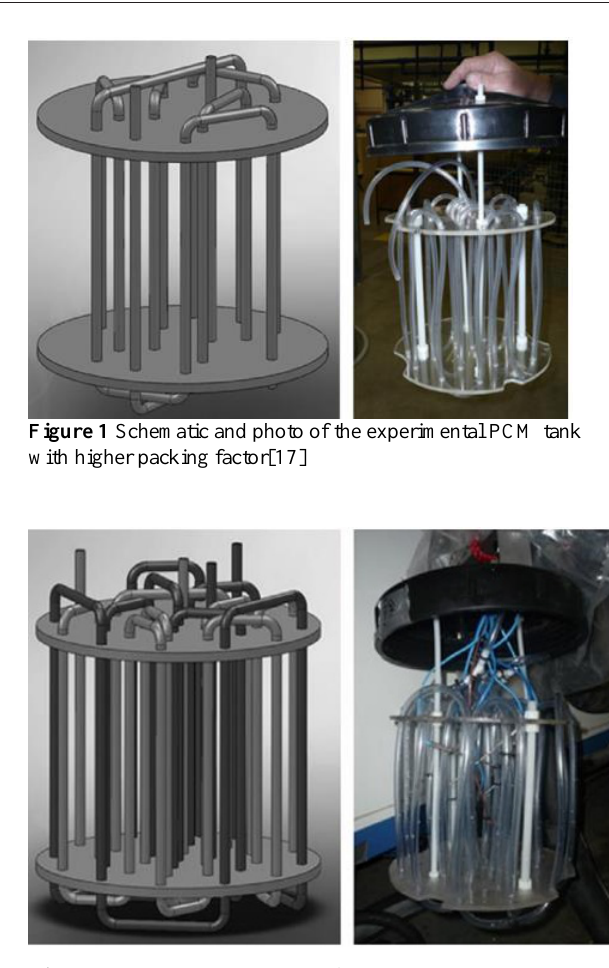
Figure 2 Schematic and photo of the experimental PCM tank with high heat transfer surface [17]